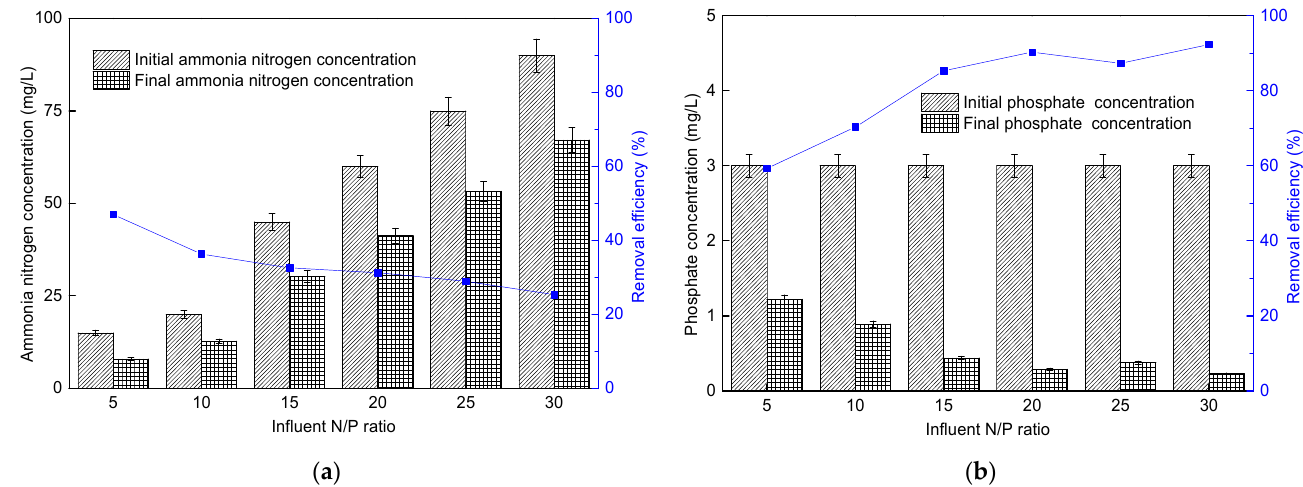
Figure 10. Changes in ammonia nitrogen ( a ) and phosphate ( b ) removal of microalgae membrane bioreactor under different influent N/P ratios at the 20th day.